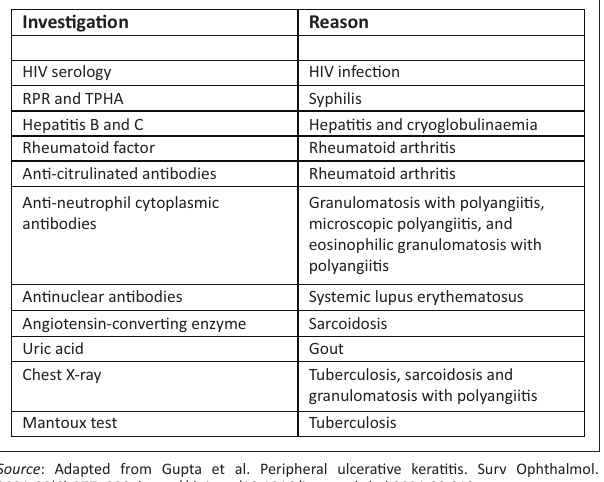
FIGURE 3: Investigations for the workup of peripheral ulcerative keratitis. TABLE 1: Conditions where a biopsy is useful to confirm the diagnosis. Disease Findings on histology Granulomatosis with